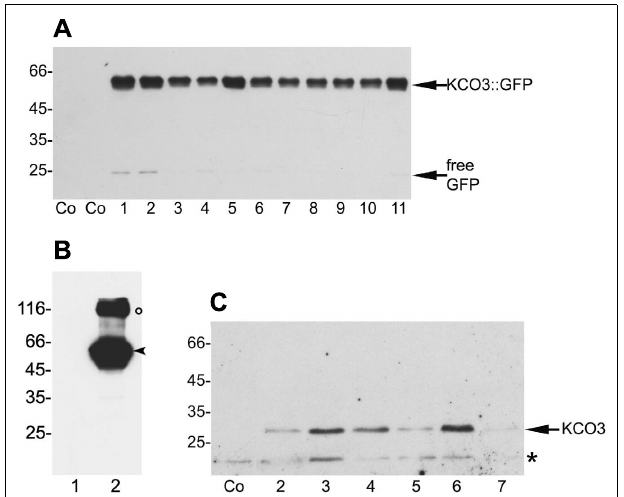
FIGURE 3 | Selection of Arabidopsis plants overexpressing KCO3::GFP and KCO3. (A) Equal amounts of leaf extracts (50 μ g of total protein) from wild-type plants (Co) and independent transgenic Arabidopsis plants expressing KCO3::GFP (plants 1–11) were subjected to SDS-PAGE and western blot analysis with anti-GFP antiserum.The positions of the entire fusion protein and of free GFP are indicated. (B) Leaf extracts from one wild-type plant (lane 1) and transgenic plant n ◦ 6 of panel A (lane 2) were analyzed by western blot using anti-KCO3 antibodies.The positions of monomers (arrowhead) and putative dimers (circle) are indicated. (C) Equal amounts (50 μ g of total protein) of leaf extracts from wild-type (Co) or independent transgenic Arabidopsis plants overexpressing KCO3 (plants 2–7) were analyzed by western blot with anti-KCO3 antiserum.The positions of KCO3 (arrow) and an unspecific, cross-reacting polypeptide (asterisk) are indicated. In each panel, numbers on the left indicate the position and size (in kDa) of molecular mass